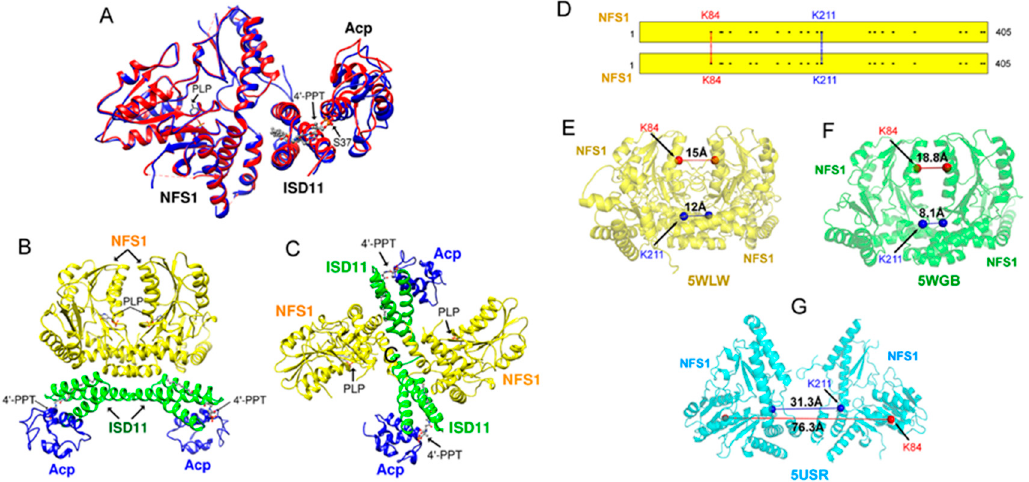
Figure 3. Investigation of structures of (NIA) 2 and (NIAU) 2 by X-ray crystallography and cross-linking as analyzed by mass spectrometry (XL-MS). ( A ) Overlay of one-half (NIA) 1 of each of two independently-determined X-ray structures of the human cysteine desulfurase complex (NIA) 2 : red, PDB entry 5WGB [92]; blue, PDB entry 5USR [125]; ( B ) X-ray structure of the full human cysteine desulfurase complex (NIA) 2 by Boniecki et al. (PDB: 5WGB) showing its “closed” conformation [92]. ( C ) X-ray structure of full human cysteine desulfurase complex (NIA) 2 by Cory et al. (2017) (PDB: 5USR) showing its “open” conformation [125]; ( D ) Experimental inter-subunit NFS1-NFS1 crosslinks in (NIAU) 2 as determined by XL-MS [129]. The maximum C α -C α distance expected for such crosslinks is 27.4 Å. This expected distance is compatible with C α -C α distances in the structures ( E ) of (NIAU) 2 (PDB: 5WLW) and ( F ) of (NIA) 2 (PDB: 5WGB) by Boniecki et al. [92] but not with C α -C α distances in the structure ( G ) of (NIA) 2 (PDB: 5USR) by Cory et al. (2017) [125]. The positions of the crosslinked lysine residues are indicated by spheres, and, for clarity, only the two NFS1 subunits are shown. Adapted from Ref. [129] with permission.